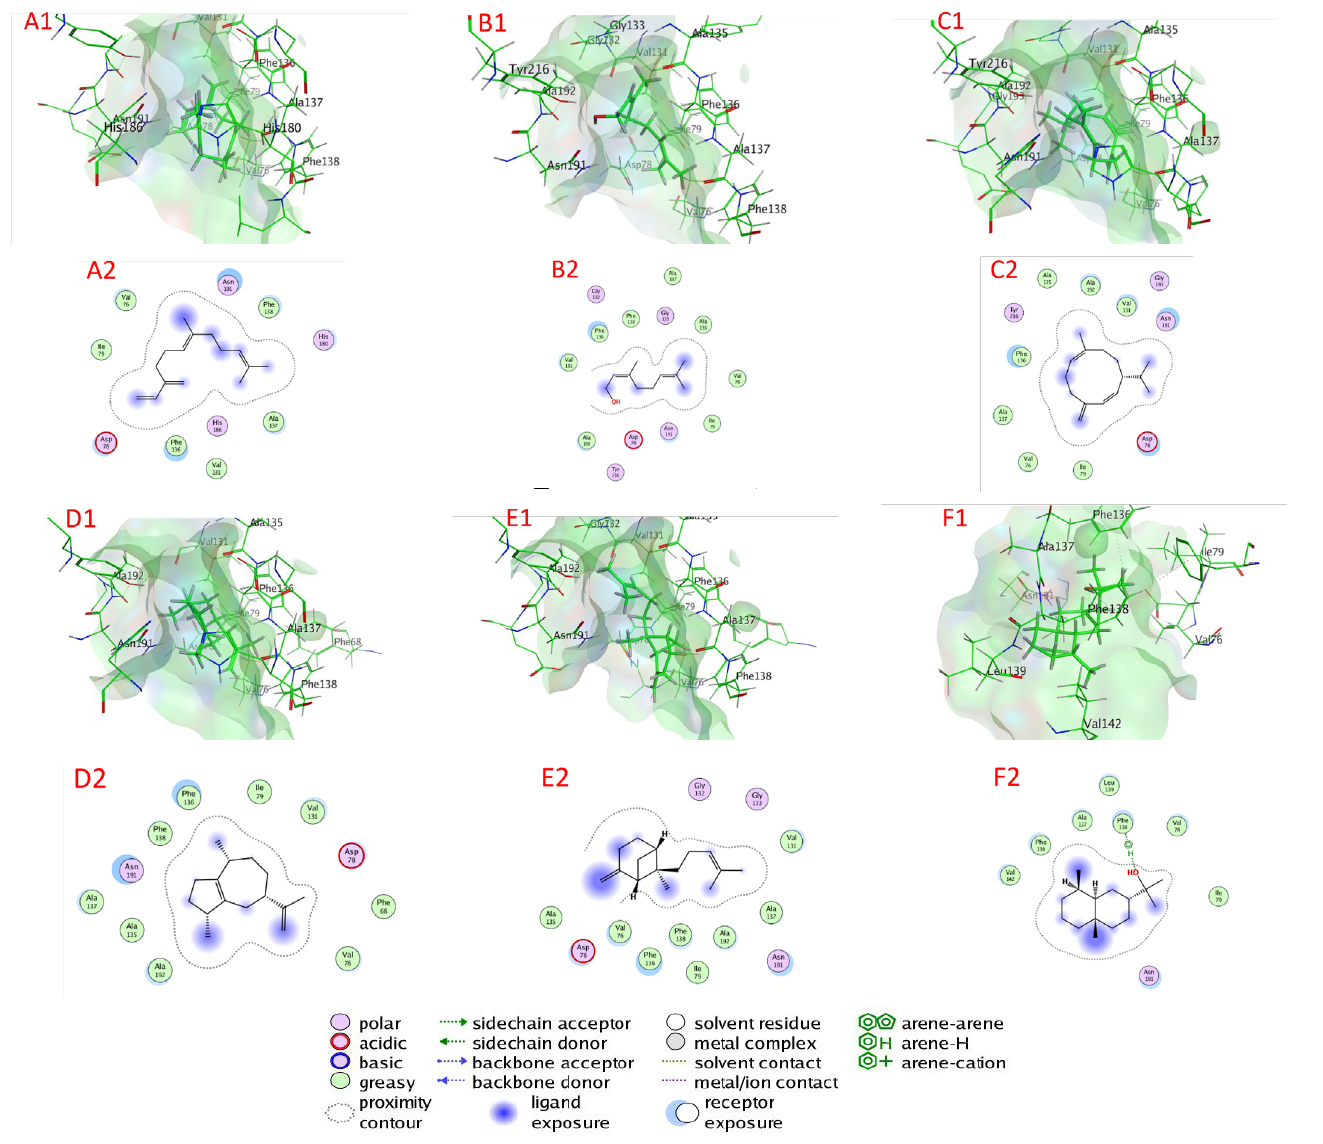
Figure 8. Docking view: ( A1 , A2 ) β -farnesene, ( B1 , B2 ) nerol, ( C1 , C2 ) germacrene D, ( D1 , D2 ) α - guaiene, ( E1 , E2 ) β -bergamotene, and ( F1 , F2 ) α -eudesmol in the binding sites of metalloprotease (PDB:1KAP). ( A1 , B1 , C1 , D1 , E1 , F1 ) 3D complex structures (stereoview) and ( A2 , B2 , C2 , D2 , E2 , F2 ) 2D interaction diagram structures.